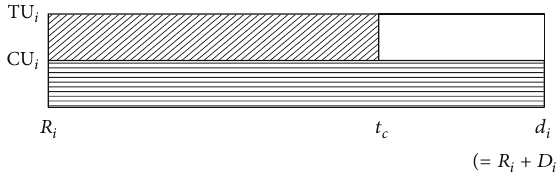
Figure 1: CC-EDF schedule and its available slack. Figure 2: A scheduling result of pinwheel task